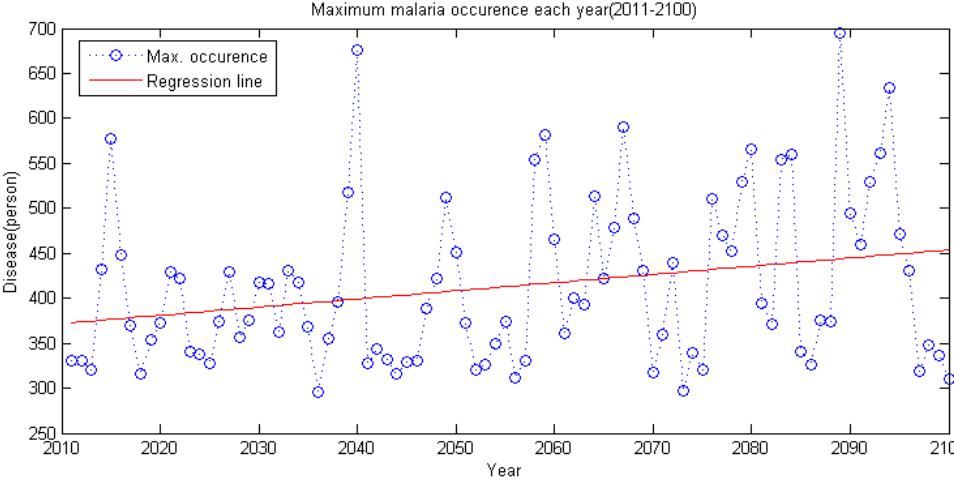
Figure 9. Annual maximum series of malaria